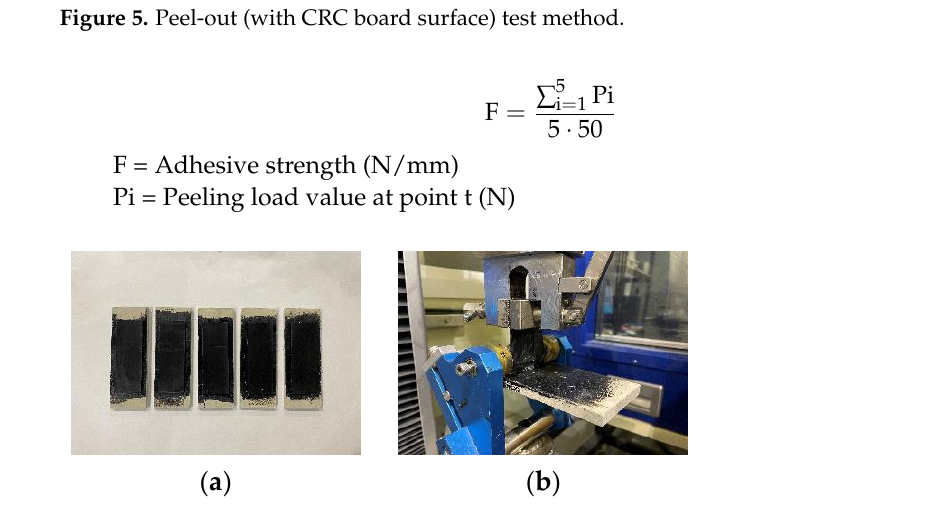
Figure 6. Peel-out (with CRC board surface) test specimen preparation and test status. ( a ) Test preparation; ( b ) Test status.